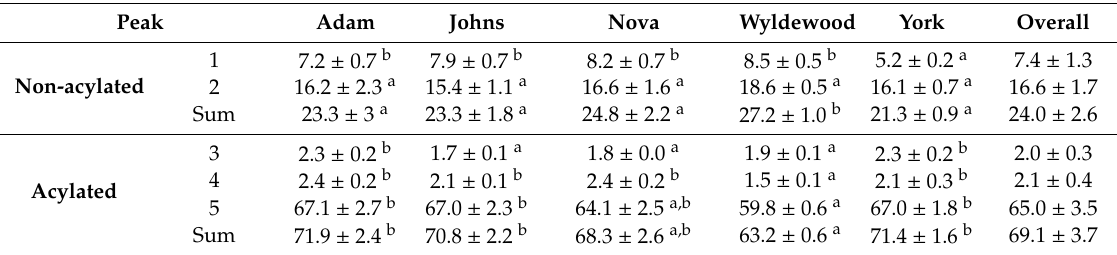
Table 2. PercentageofindividualanthocyaninindifferentAmericanelderberrycultivars. Anthocyaninsare listedintheorderofelution. Resultsexpressedasmean ± SD( n = 3). Cultivarswithdi ff erentsuperscripts were significantly di ff erent ( p < 0.05).